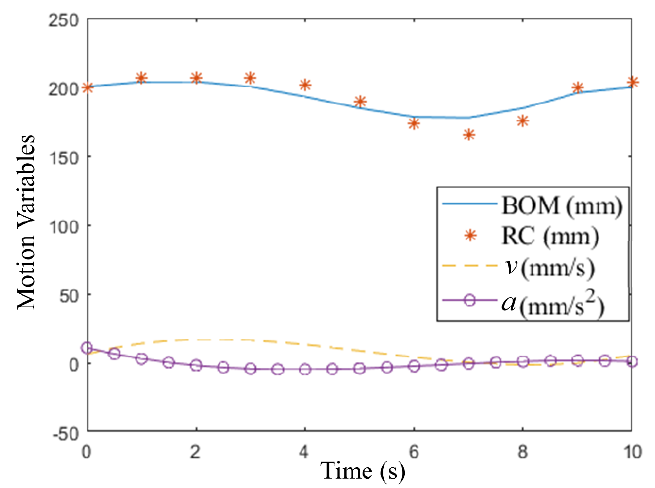
Figure 11. Variation in the motion of two types of manipulators in a configuration space.